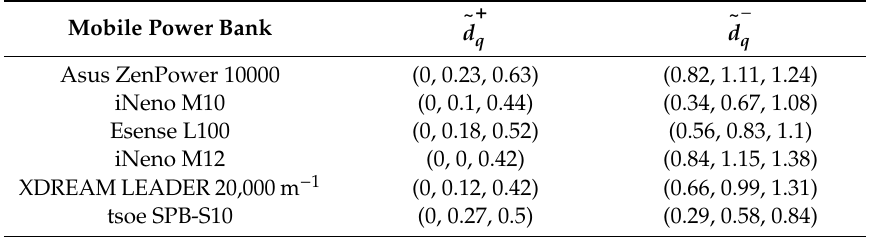
Table 7. Distances between each mobile power bank and the two reference